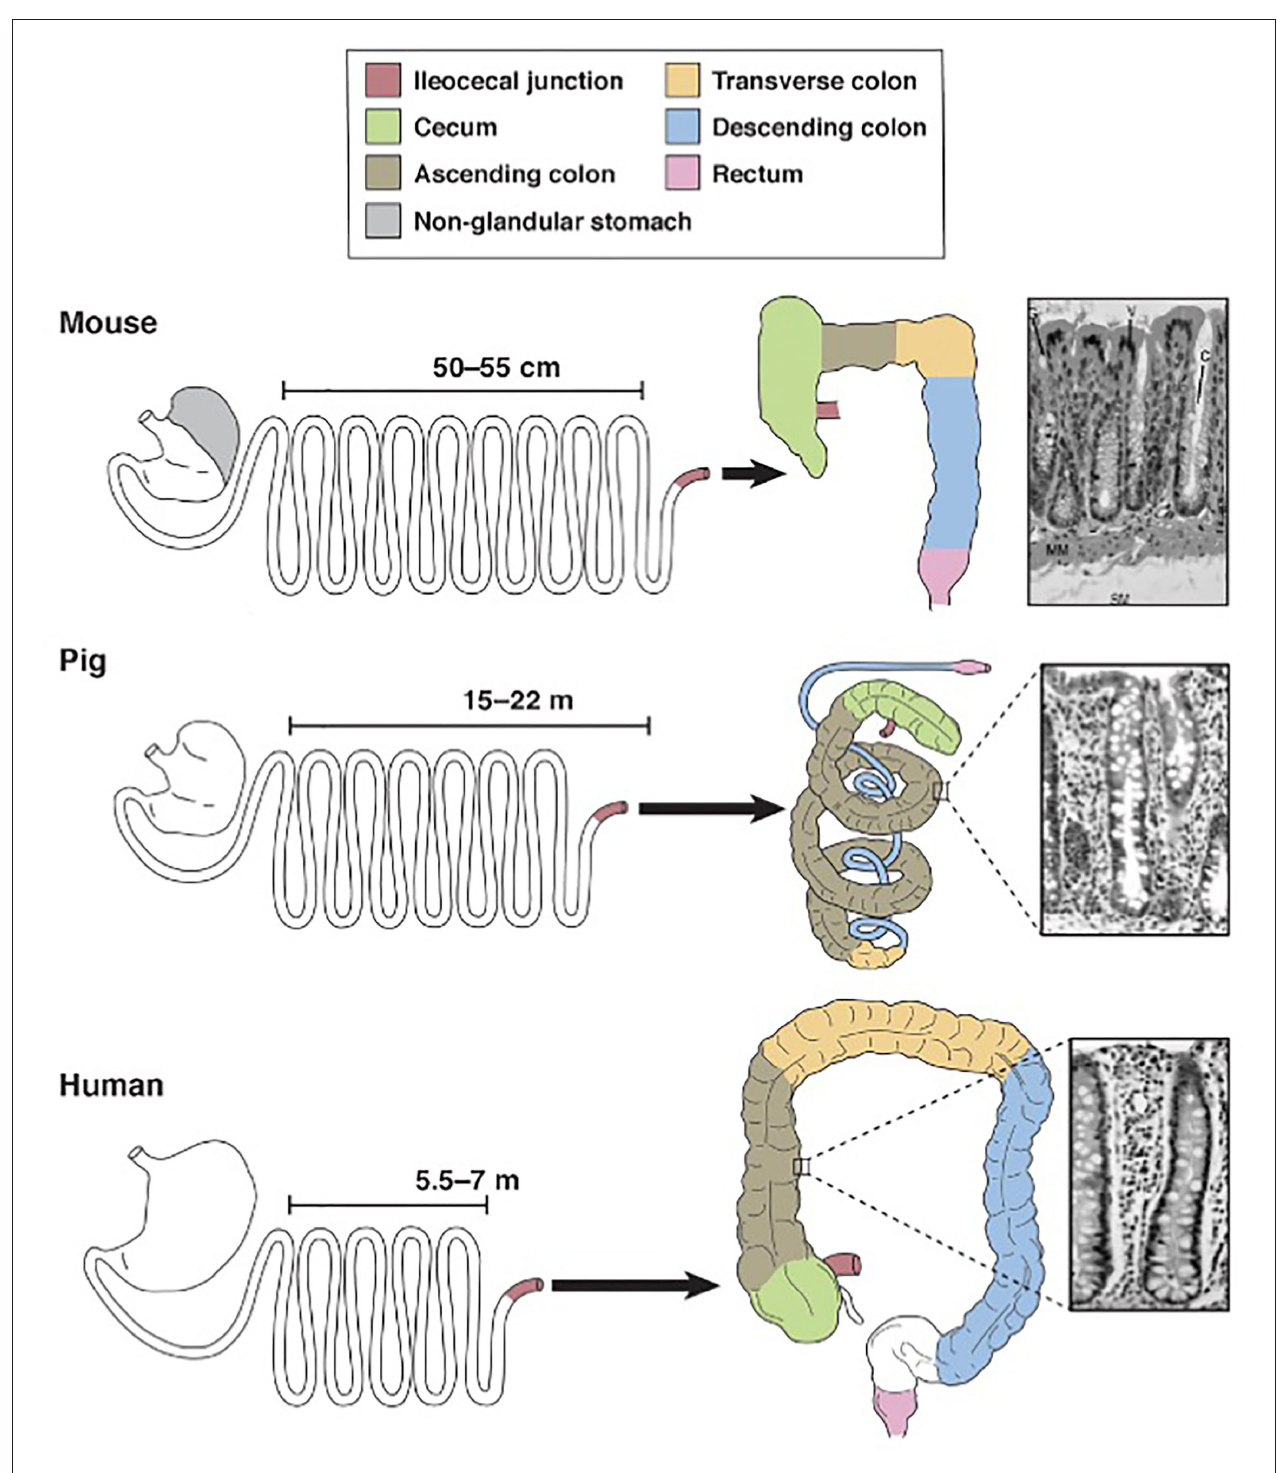
FIGURE 1 | Schematic diagram for comparison of mouse, pig and human gastrointestinal tract anatomy. Derived from Ziegler et al. (13). of and interaction with gut commensals. Conversely, several Peyer’s patches many functions is to discriminate between researchers argue that these differences between pig and human pathogenic and commensal bacteria, we can speculate that this Peyer’s patches are of limited significance because pigs interspecies variability may provoke distinct host perception